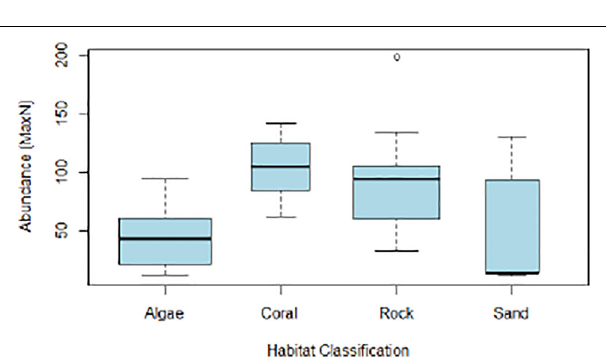
FIGURE 7 | Range of abundance (MaxN) values recorded within each habitat